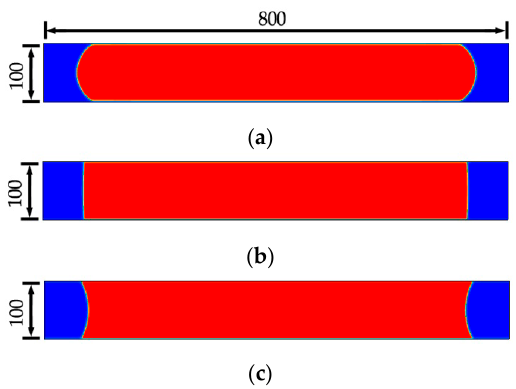
Figure 7. Fluids in a rock micro-fracture with different contact angles: ( a ) θ = 148.7 ◦ ; ( b ) θ = 92.6 ◦ ; ( c ) θ = 61.9 ◦ .